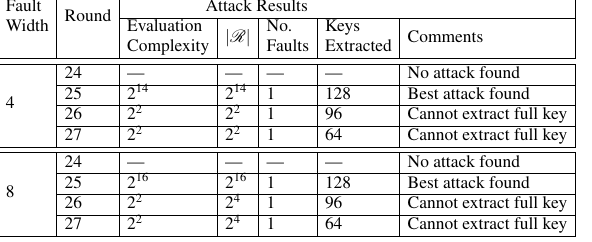
Table 3: Summary of DFA attacks on GIFT. We consider a fault injection attempt a successful attack only if both the evaluation complexity and | R | is less than the size of the key space. Fault Attack Results Width Round